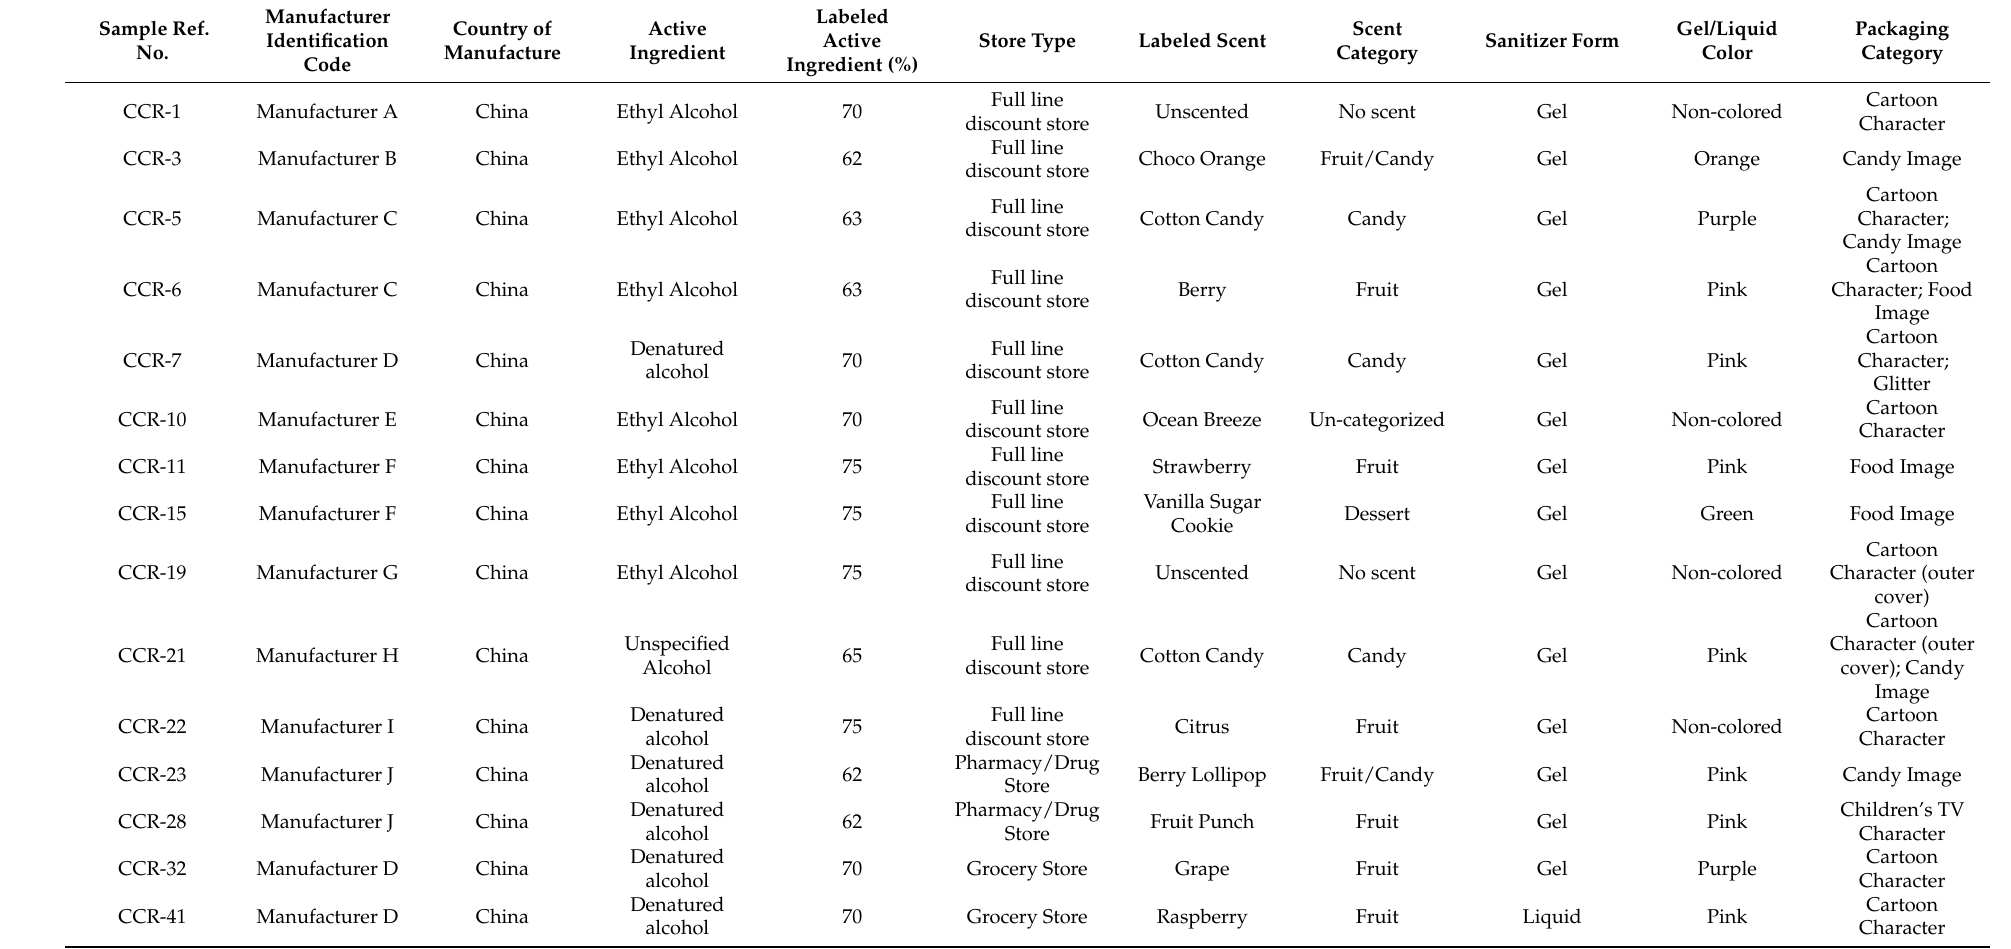
Table 3. Selection of Hand Sanitizers Marketed to Children Tested for